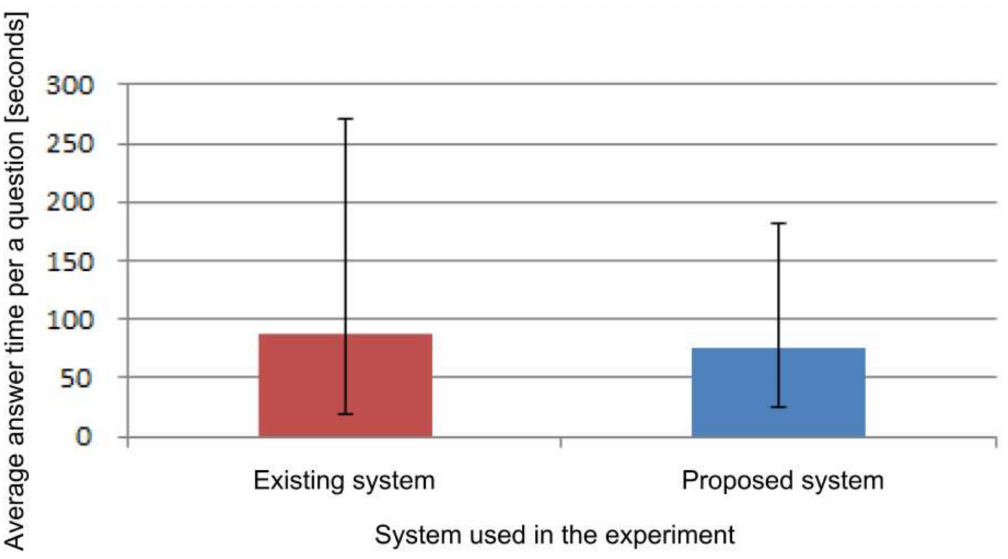
Figure 15. Average answer time per question for all 10 questions in Experiment